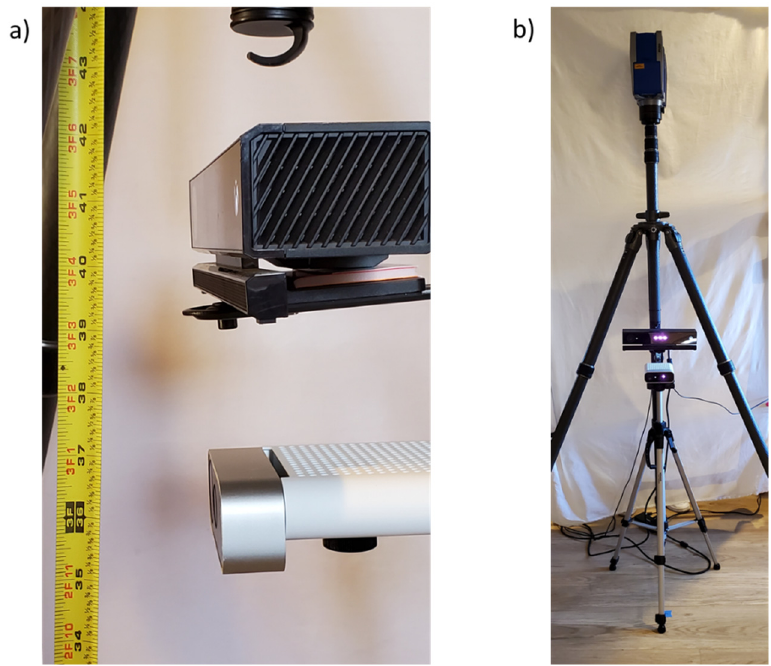
Figure 1. ( a ) The Kinect v2 (above) and Kinect Azure (below) are shown with a tape measure positioned vertically from the ground up for reference, and ( b ) both Kinect sensors are mounted on a tripod with a FARO 3D laser scanner positioned directly above.